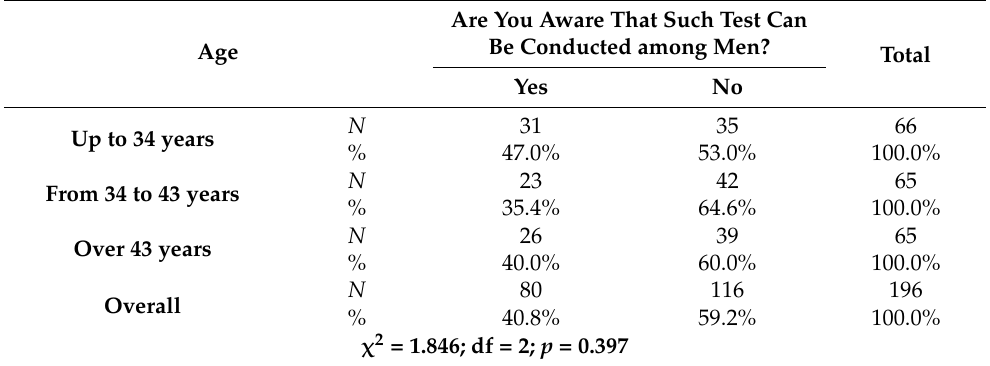
Table 5. Results from analyzing the relationship between the age of the respondents and the awareness that HPV test can also be conducted among men. Are You Aware That Such Test Can Be Conducted among Men? Total Age Yes No N 31 35 66 Up to 34 years % 47.0% 53.0% 100.0% N 23 42 65 From 34 to 43 years % 35.4% 64.6% 100.0% N 26 39 65 Over 43 years % 40.0% 60.0% 100.0% N 80 116 196 Overall % 40.8% 59.2% 100.0%